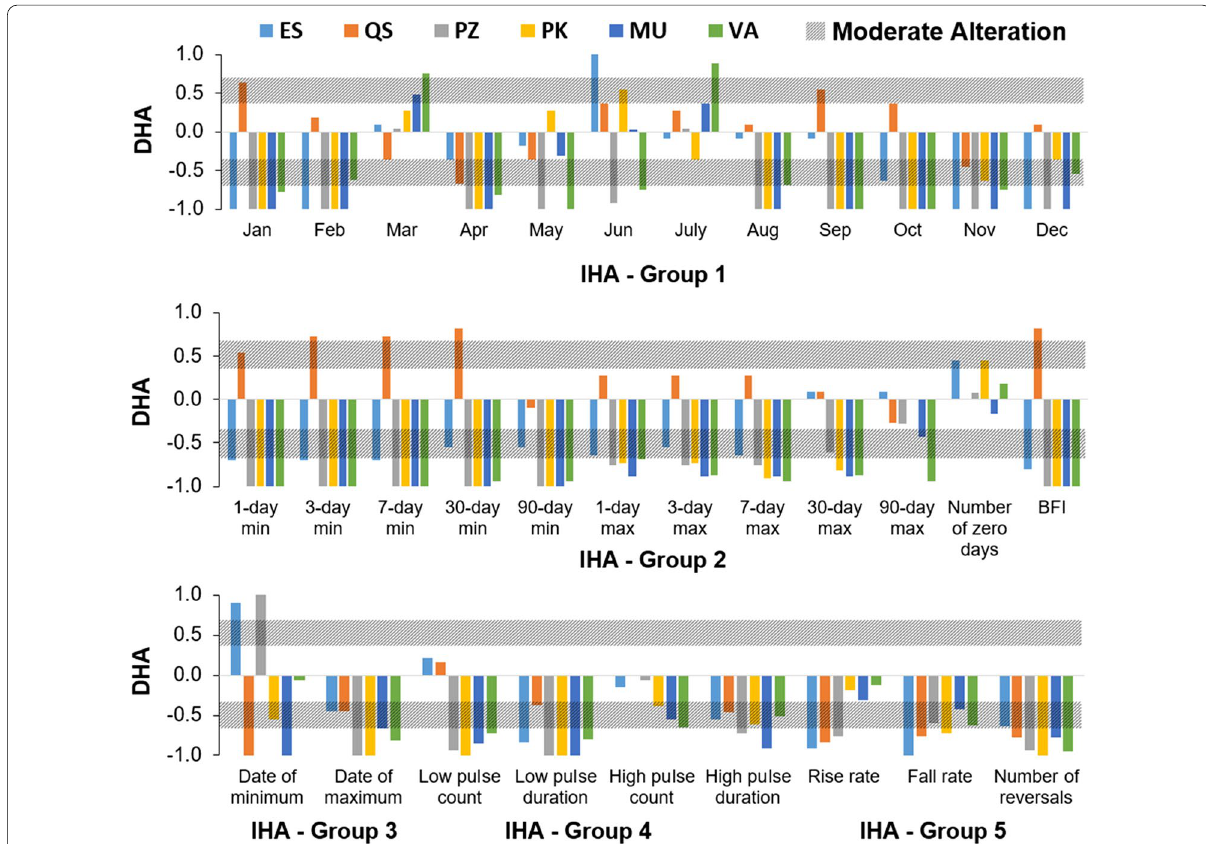
Fig. 4 Degree of hydrologic alteration (DHA) along the Zayandeh-Rud River (HAB: High alteration boundary, LAB: Low alteration, ES: Eskandari,